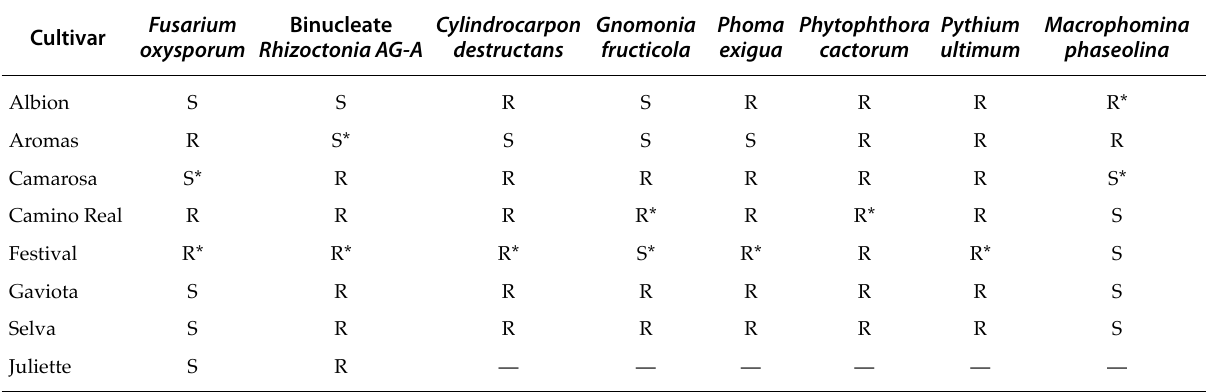
Table 8. Summary matrix of the response of the eight strawberry cultivars to eight different fungal and oomycete patho - gens (‘S’ = susceptible and ‘R’ =